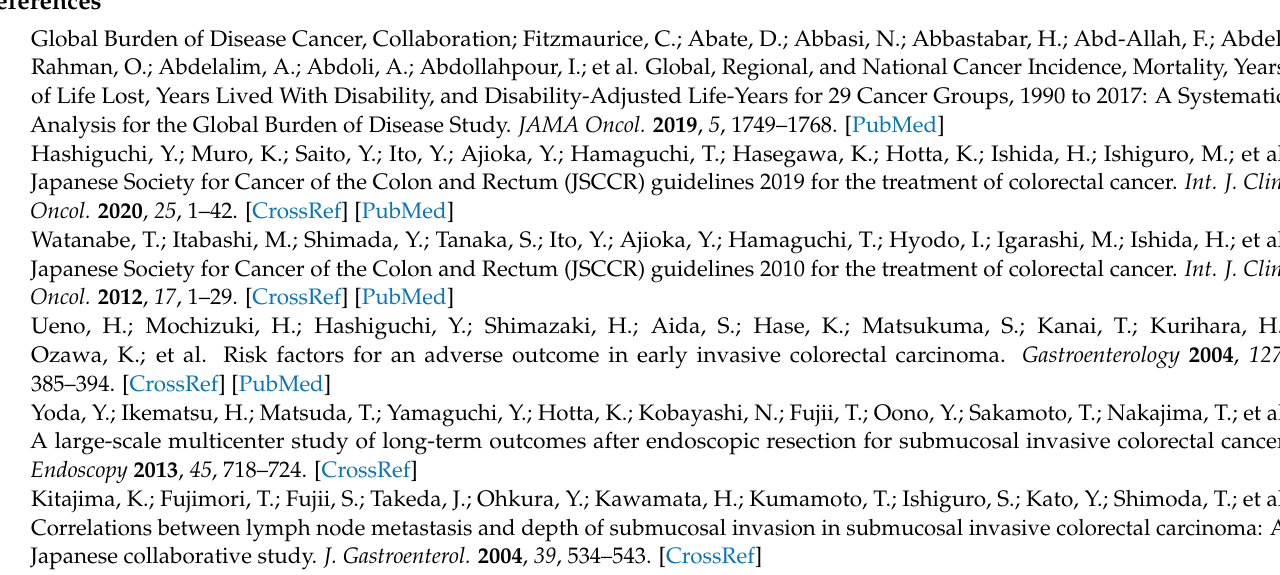
Figure S4: Decision tree to predict lymph node metastasis and recurrence, Figure S5: Decision tree to predict lymph node metastasis and recurrence in the validation cohort, Table S1: Lymph node metastasis stratified according to submucosal invasion depth in the high-risk pT1 CRC, Table S2: Risk factors for overall survival in the high-risk group with surgical resection. Table S3: Validation cohort of the high-risk pT1